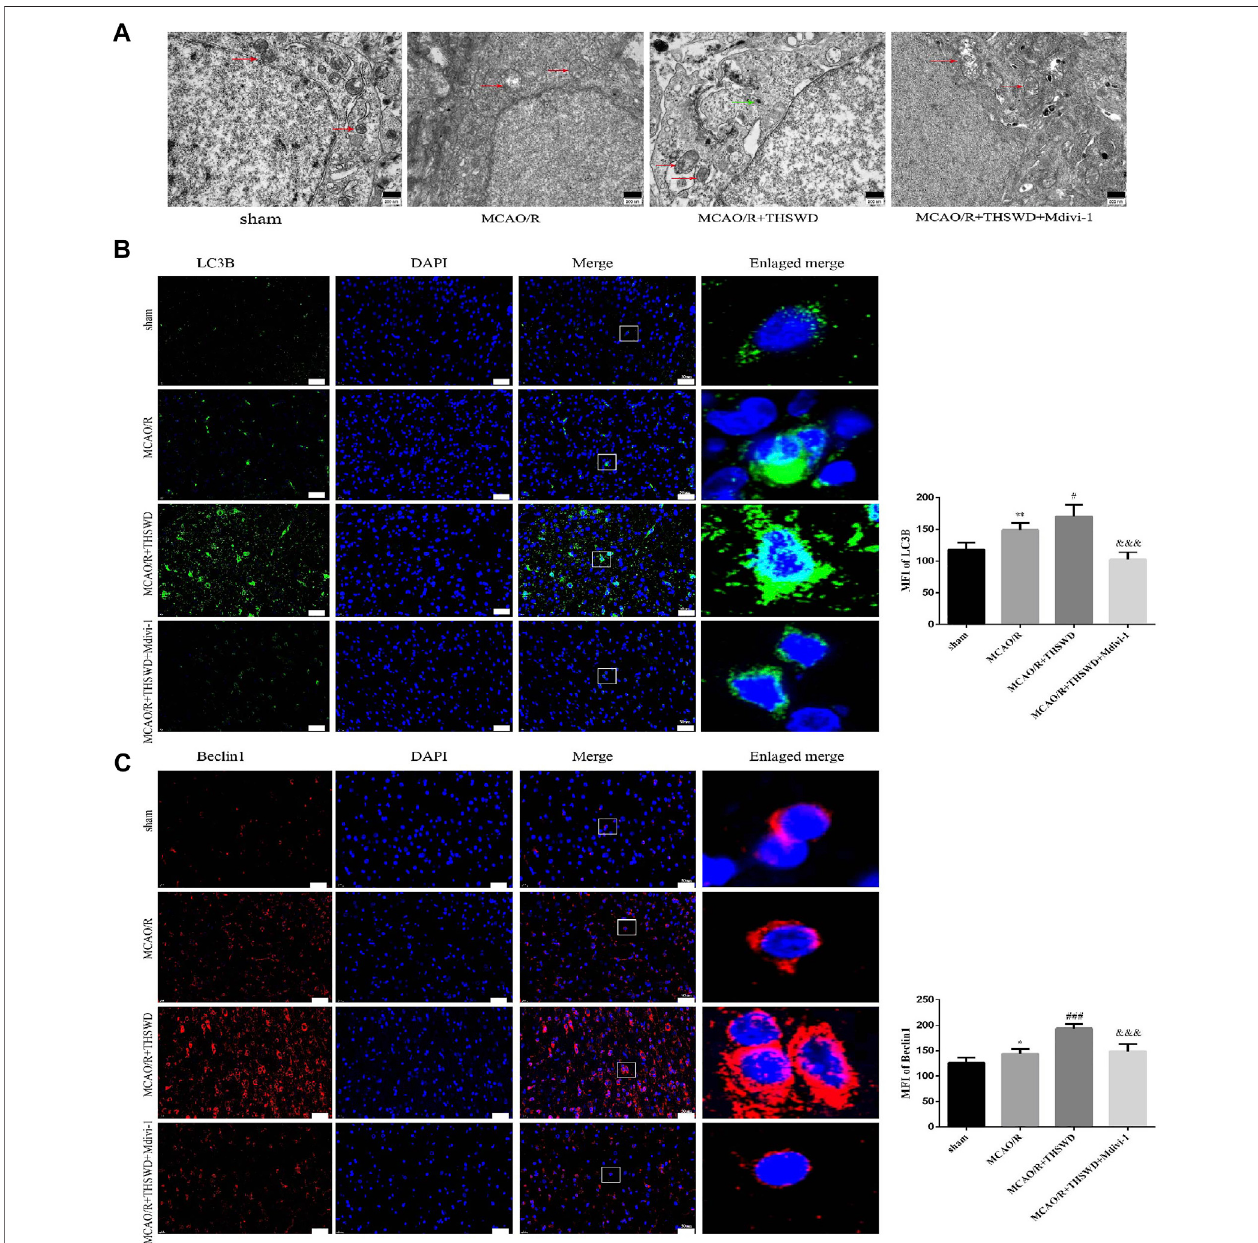
FIGURE3| EffectsofTHSWDtreatmentonMitochondrialstructureandautophagyproteins. (A) Ultrastructuralchangesinmitochondria.Scalebar=500 nm.The red arrows marked the mitochondria,and the green arrows marked the many autophagic vesicles that wrapped around the mitochondriaand fused with thelysosomes in the MCAO/R + THSWD group. (B , C) Immuno fl uorescence staining of LC3B and Beclin1 (×400). Scale bar = 50 μ m. The mean fl uorescence intensities (MFI) of LC3B and Beclin1 are quanti fi ed in the right-hand histogram. n = 4 per group. * p < 0.05, ** p < 0.01 versus sham group, # p < 0.05, ### p < 0.001 versus MCAO/R group, &&& p < 0.001 versus MCAO/R + THWSD